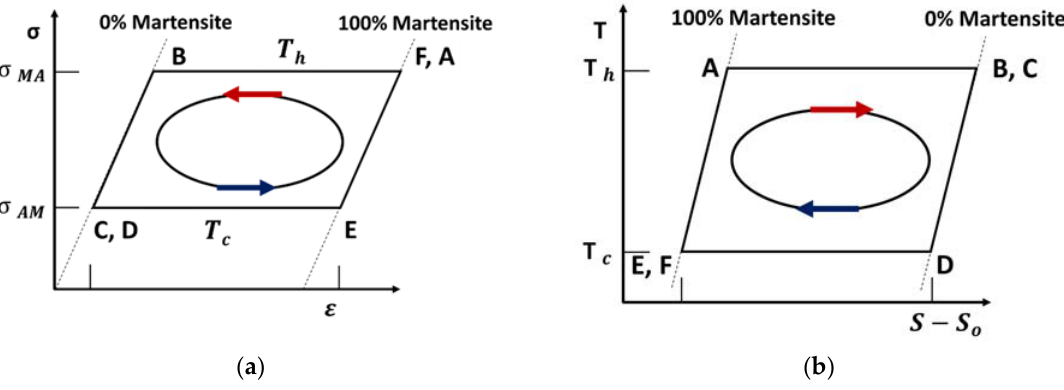
Figure 23. Thermoelastic cycles. ( a ) Stress-strain ( σ - ε ) diagram; ( b ) Temperature-entropy ( T - S ) diagram.